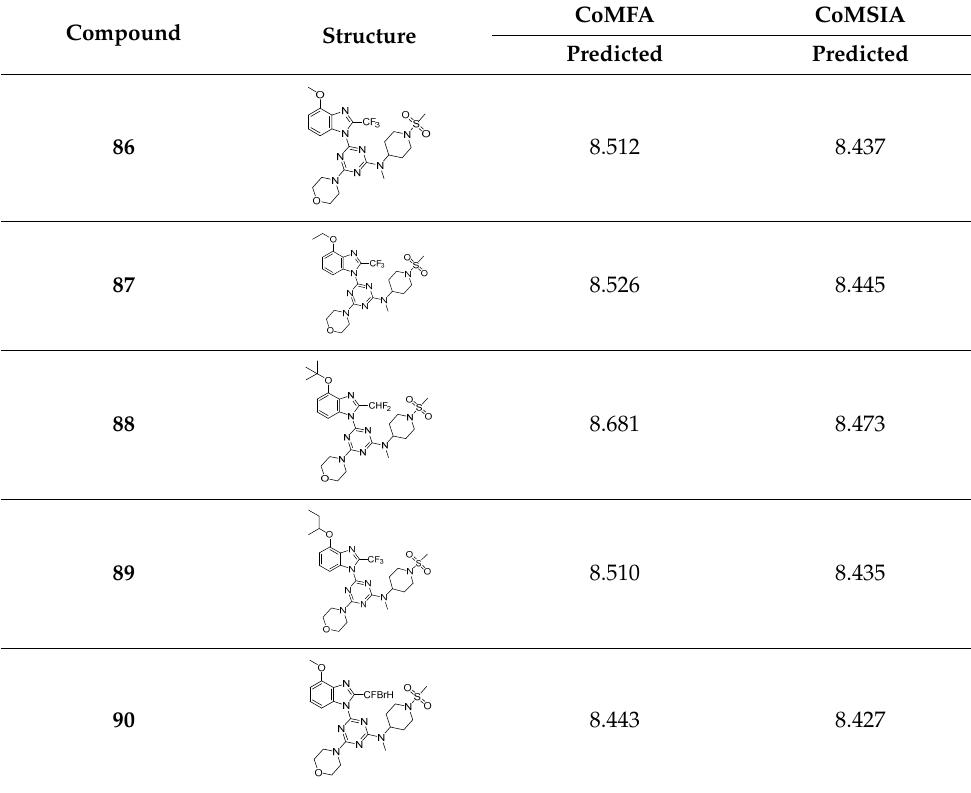
Table 2. Structures of the compounds with predicted activity. Compound